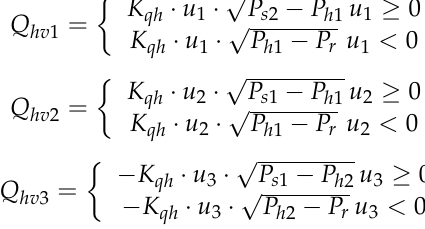
ω v is the natural frequency of the valve; ζ is the damping